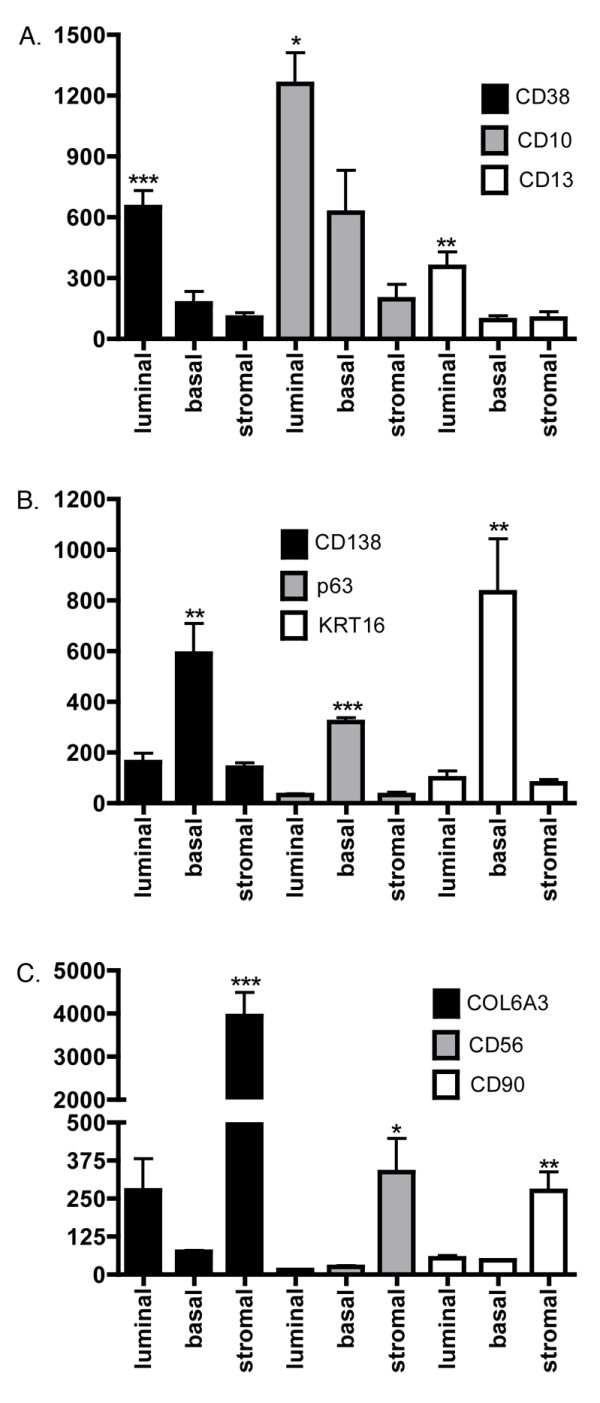
Prostate cell specific genes. Expression levels of genes that are documented in the literature as being expressed by prostate luminal secretory (A), basal epithelial (B), or stromal fibromuscular (C) cells was determined from Affymetrix GeneChip data. ANOVA results indicate significantly different expression at P < 0.001 (***), P < 0.01 (**), and P < 0.05 (*).